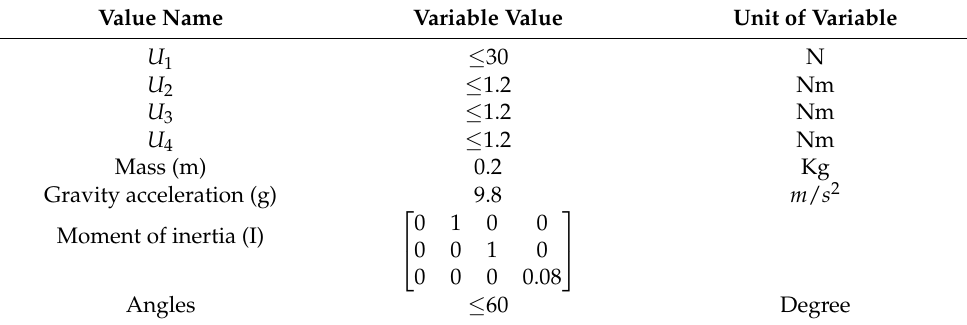
Table 3. Control input values.